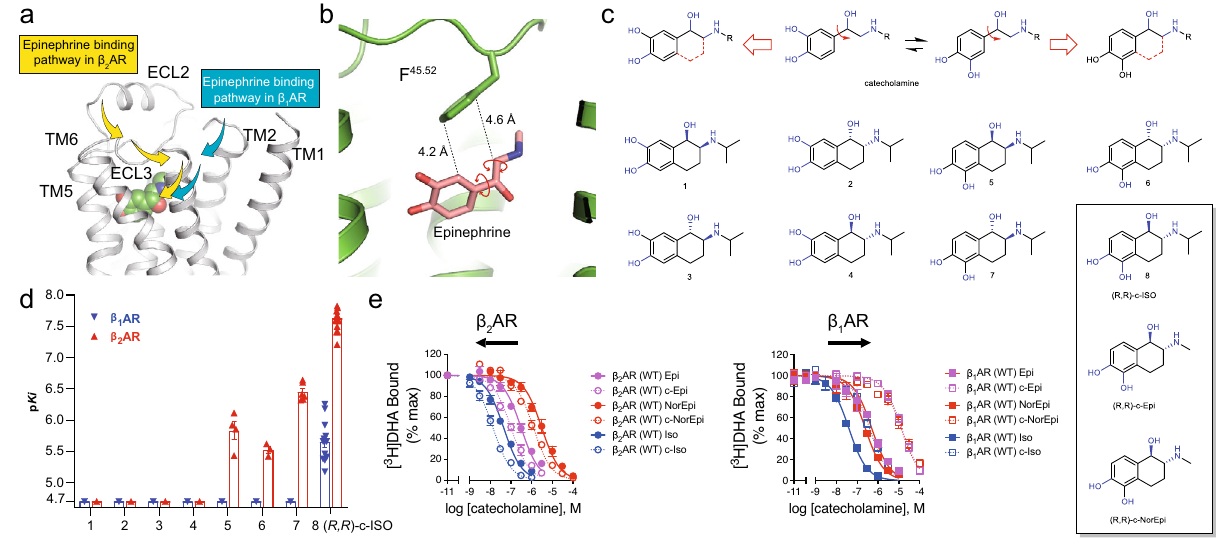
Fig. 1 | Design and synthesis of conformationally-constrained catecholamine. a Epifavorsdifferentbindingpathwaystoentertheorthostericpocketsinthe β 1 AR and β 2 AR 7 . b There is space between Epi and F 45.52 to allow the receptor to accommodate for the conformational restriction of the catecholamine (PDB: 4LDO). c The design and synthesis fl ow of eight possible conformationally- constrained isoprenaline isomers and the chemical structures of (R,R)-c-Epi and (R,R)-c-NorEpi. d The (R,R)-isomer of c-ISO showed the highest af fi nity to both the β β 1 AR and 2 AR among all the eight possible isomers. Data were given as mean±